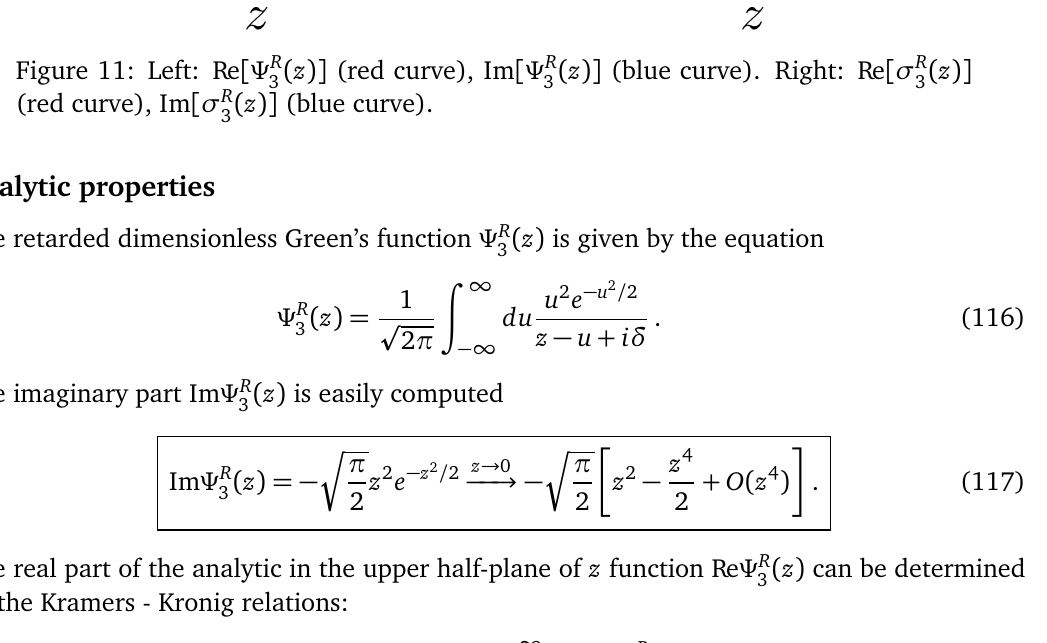
( z )] (blue curve). Right: Re [ σ R 3